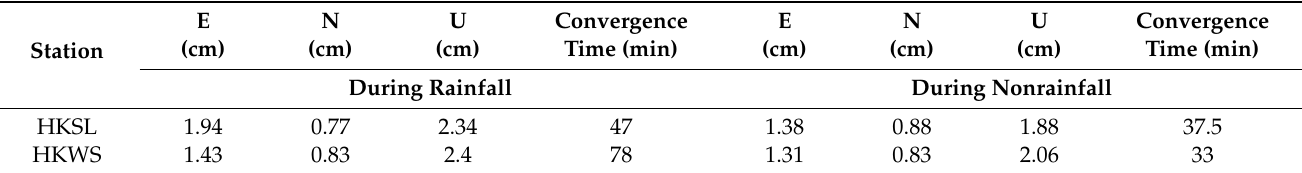
Table 4. Positioning error and convergence time of real-time multi-GNSS PPP.